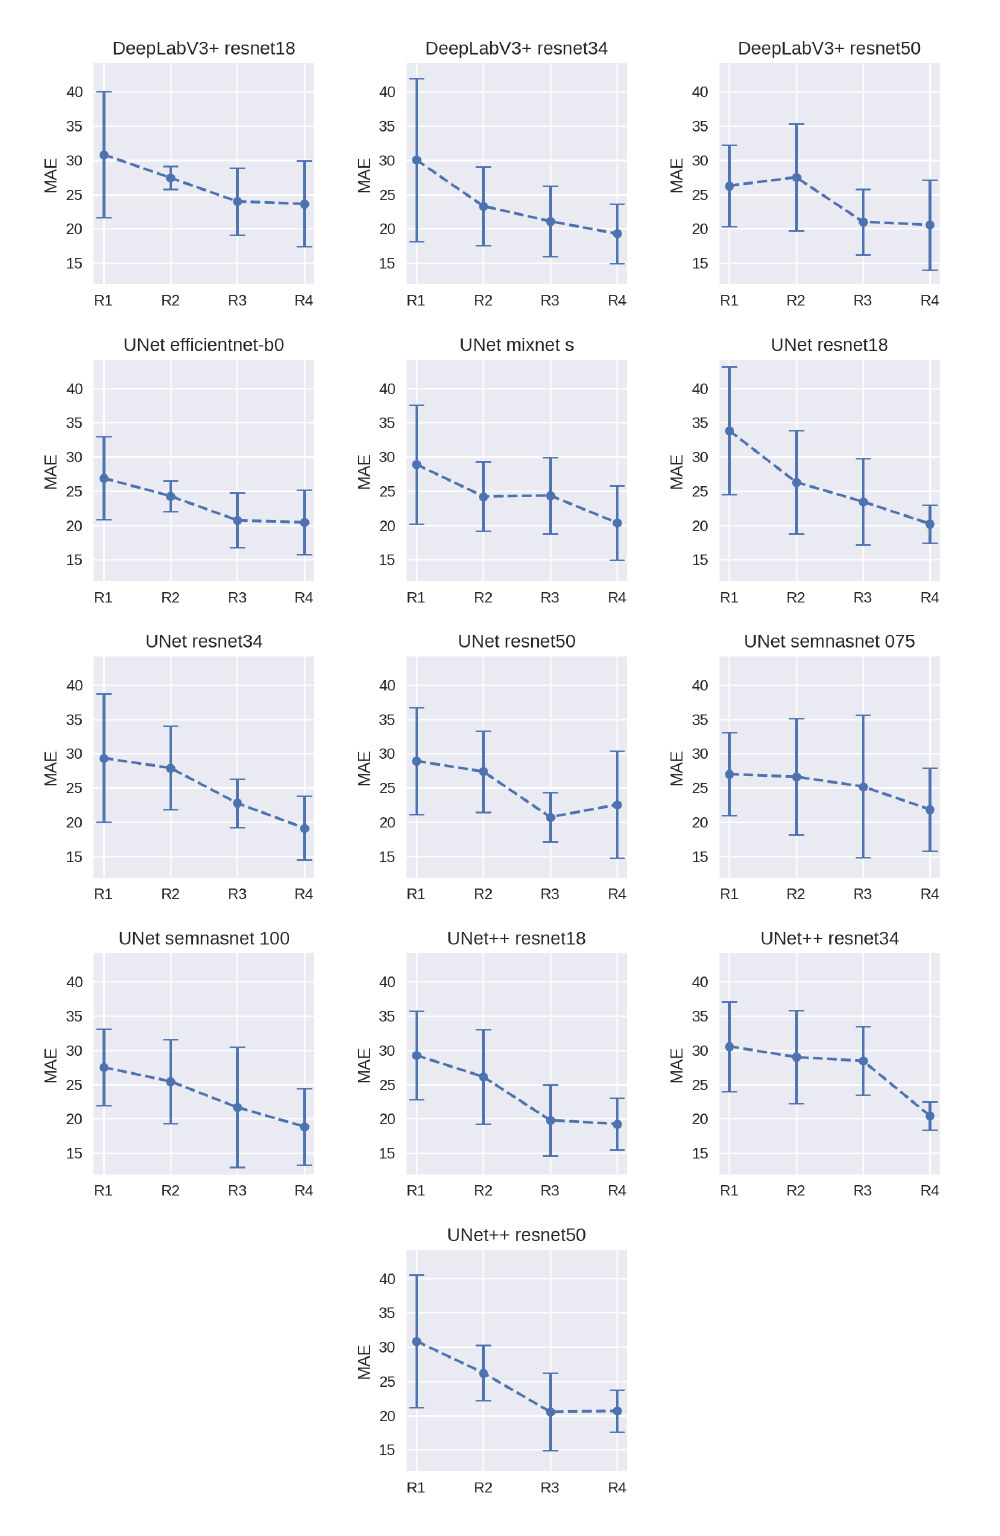
Figure 7. The visualisation of model results (People MAE) for various input image resolutions benchmarked on the Jetson NX platform. R1–R4 represent the following input sizes: 480 × 288, 640 × 384, 960 × 540, and 1280 × 736. All the subdiagrams are represented on the same axis